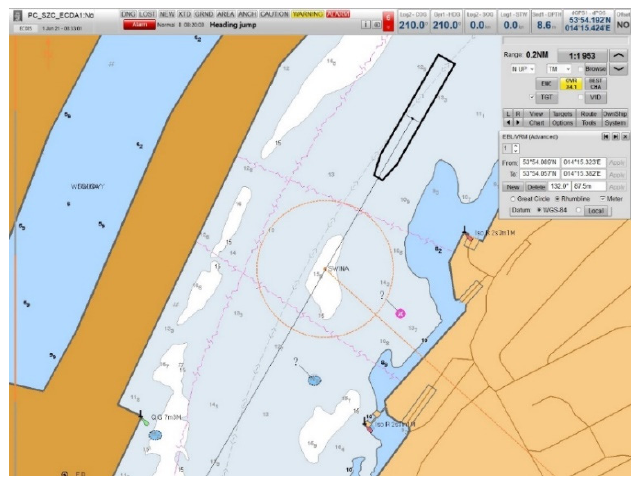
Figure 6. ECDIS display with berthing approach marked by EBL, VRM.